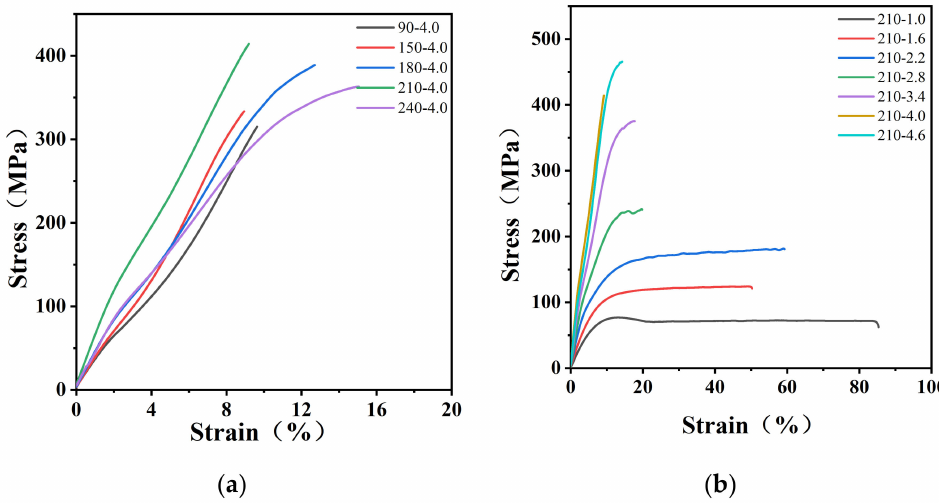
Figure 1. Stress–strain curves of PA12T samples with ( a ) different stretching temperatures; ( b ) different stretching ratios.